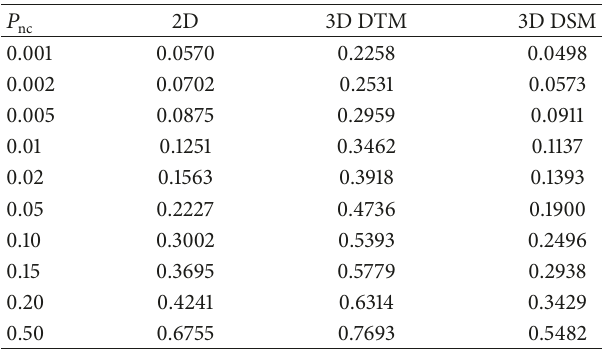
Table 5: Comparison of empirical cumulative frequencies at design 𝑃 values. nc